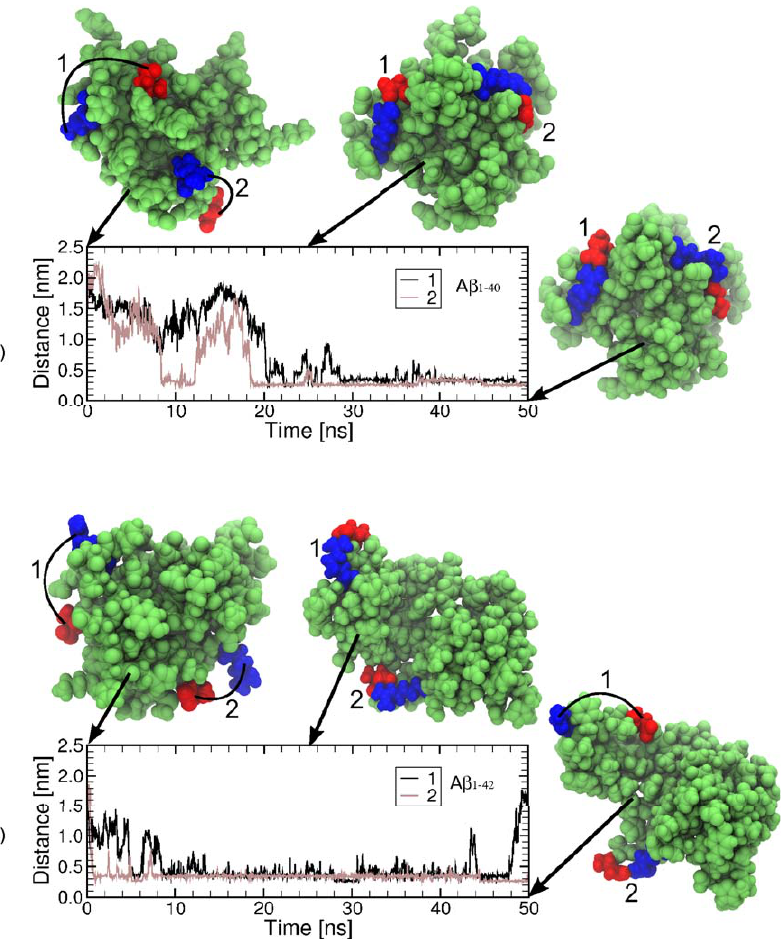
Figure 7. Intrapeptide salt bridge formation between D1 and R5 in A b 1 { 40 and A b 1 { 42 dimers in SPCE water model. The dimers are colored in green, D1 in red and R5 in blue. The distance between one oxygen of D1 side chain and one nitrogen of R5 side chain for each of the two peptides in a (A) A b 1 { 40 and (B) A b 1 { 42 dimer is shown as a function of simulation time. The D1-R5 salt bridges on each of the two peptides in a dimer are marked as 1 and 2.